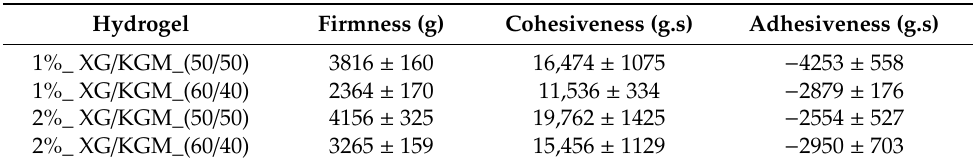
Table 1. Texture analysis of XG / KGM